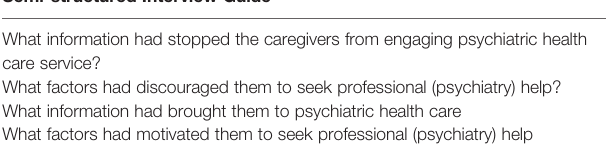
TABLE 1 | Semi-structure interview guide. Semi-structured Interview Guide